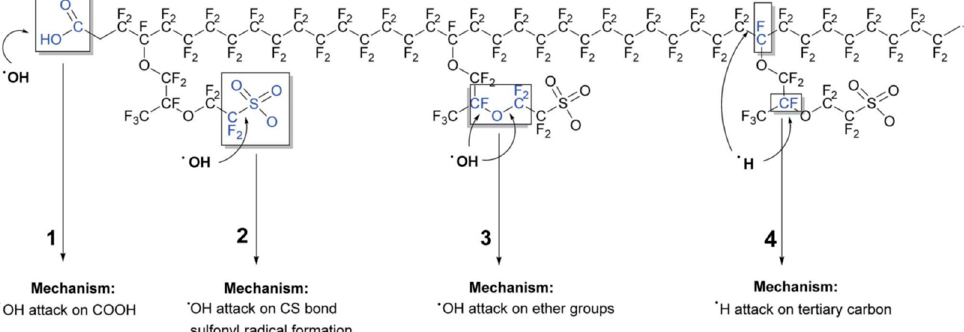
Figure 3. Summary of the mechanisms of radical attack on the Nafion ® polymer structure [25].